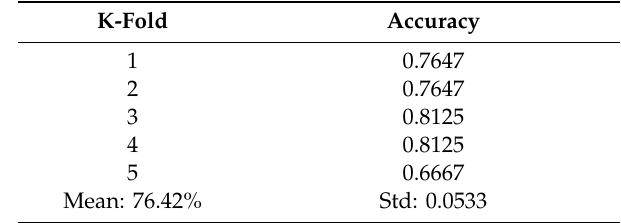
Table 9. Accuracies achieved by performing 5-Fold Cross-Validation on the SVM-Polynomial model.